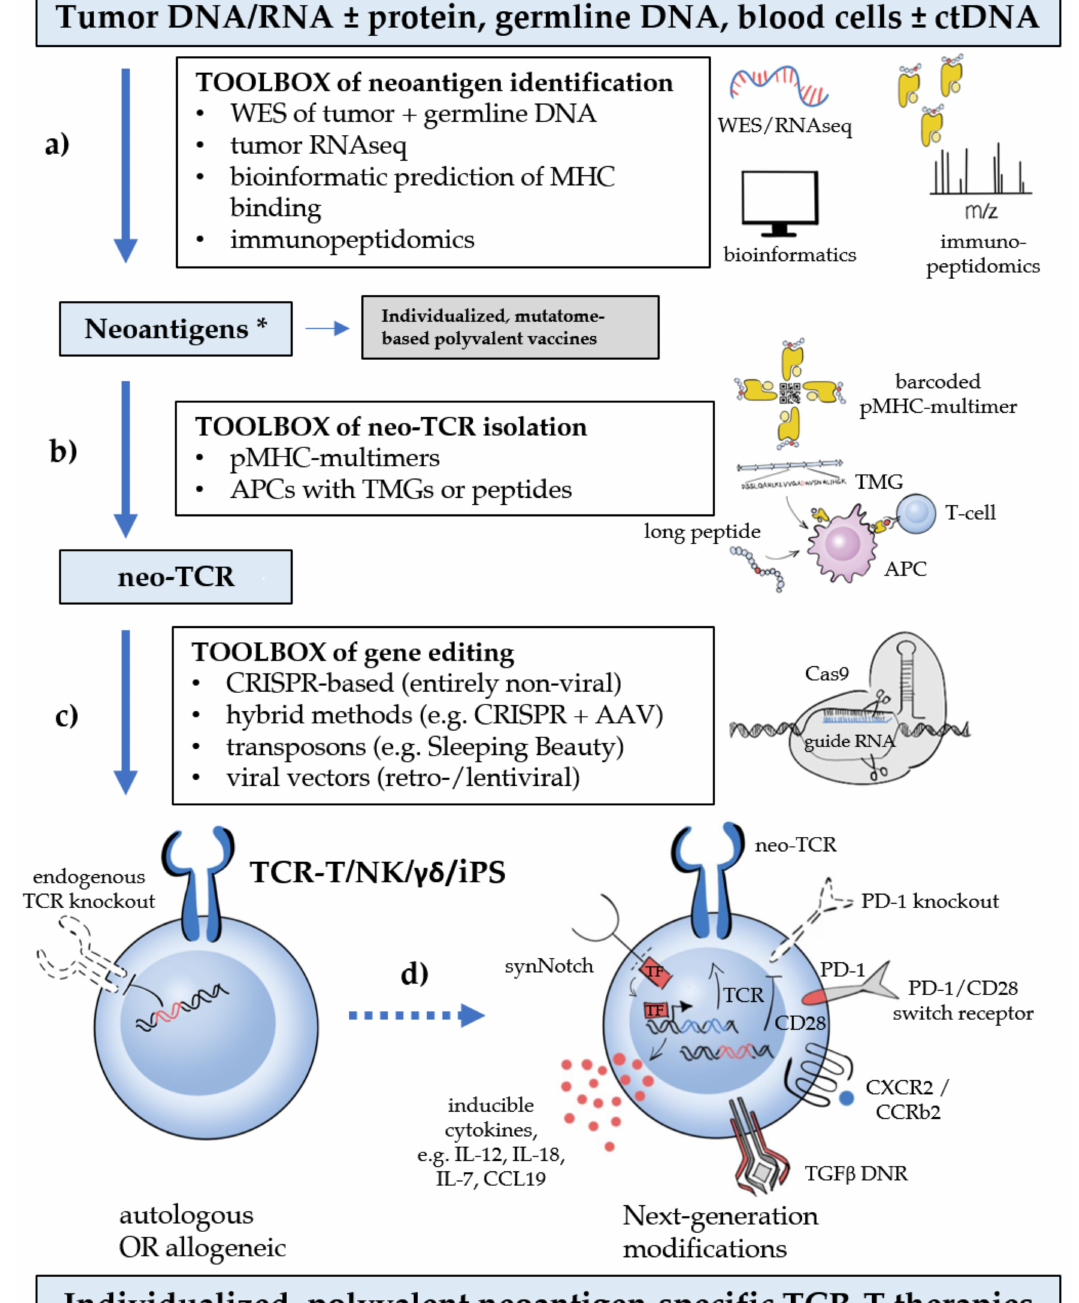
Figure 1. Critical steps, bottlenecks, and breakthroughs in neoantigen-based T-cell-receptor (TCR) therapy. Critical steps (blue boxes), bottlenecks (shown with lower-case letters: ( a ) rapid, high-throughput identification of public and private neoantigens; ( b ) isolation of neoepitope-specific TCRs (neo-TCRs); ( c ) (preferably non-viral) gene editing of autologous or allogeneic cells with concomitant knock-out of the endogenous TCR; ( d ) additional next-generation modifications to improve T-cell physiology), and technological breakthroughs (white boxes) that drive progress in the TCR therapy of cancer. The term “third-generation ACTs” has been coined for products combining these new technologies [18]. Polyvalency currently entails manufacturing multiple mono-specific TCR-T cells, which are then pooled together or sequentially infused to the patient. * in case of virally induced tumors, oncoviral antigens are also tumor-specific and can be exploited similarly to the tumor